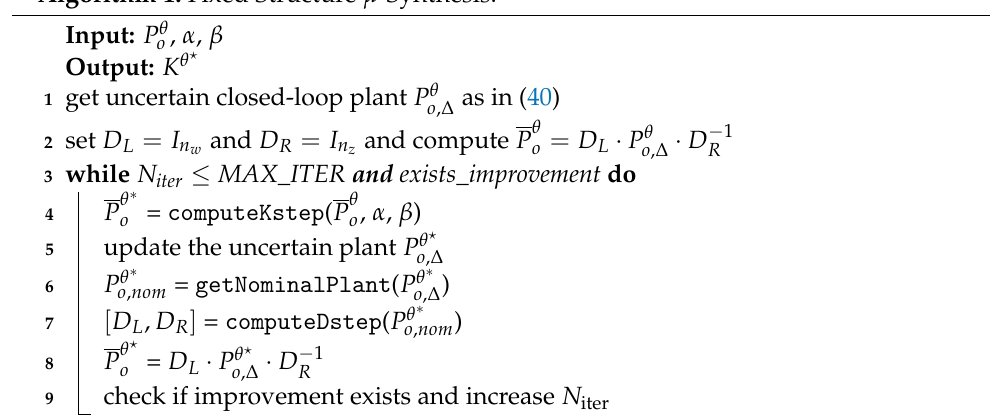
Algorithm 1: Fixed Structure µ